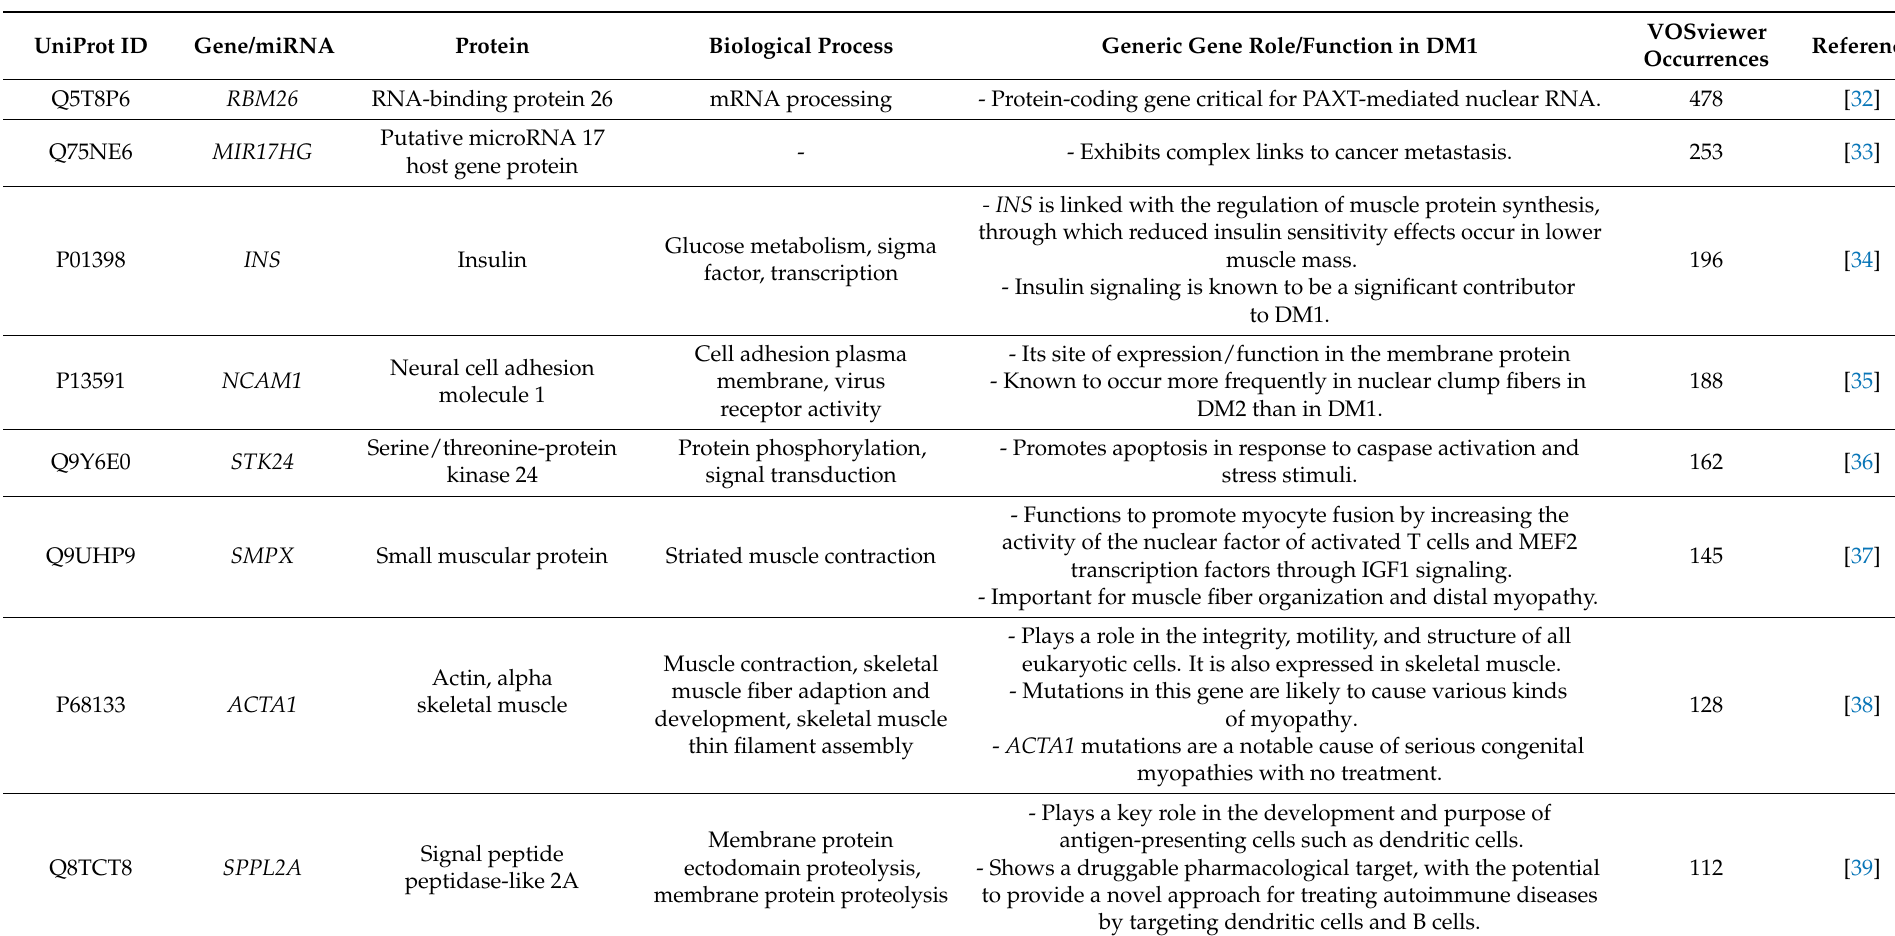
Table 3. Summary of the 71 potential novel molecular targets for DM1 that were not previously associated with the disease in DisGeNET and the correspondent VOSviewer occurrence score. ProteomicsDB and UniProt were used to investigate biological processes in which these 71 genes